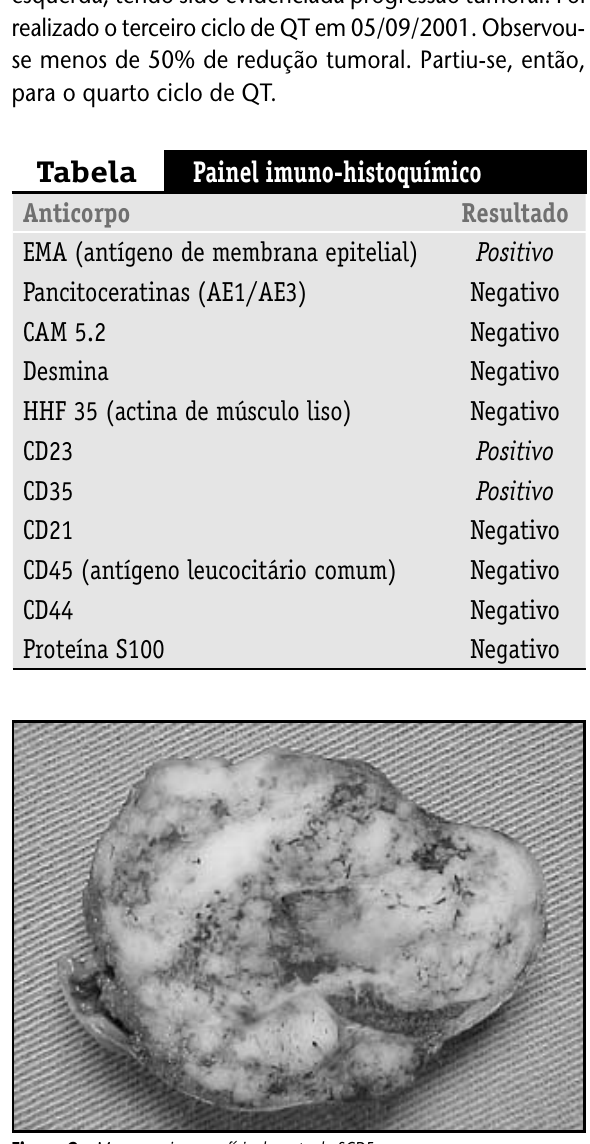
Figura 1 – Macroscopia: superfície externa do SCDF Figura 2 – Macroscopia: superfície de corte do